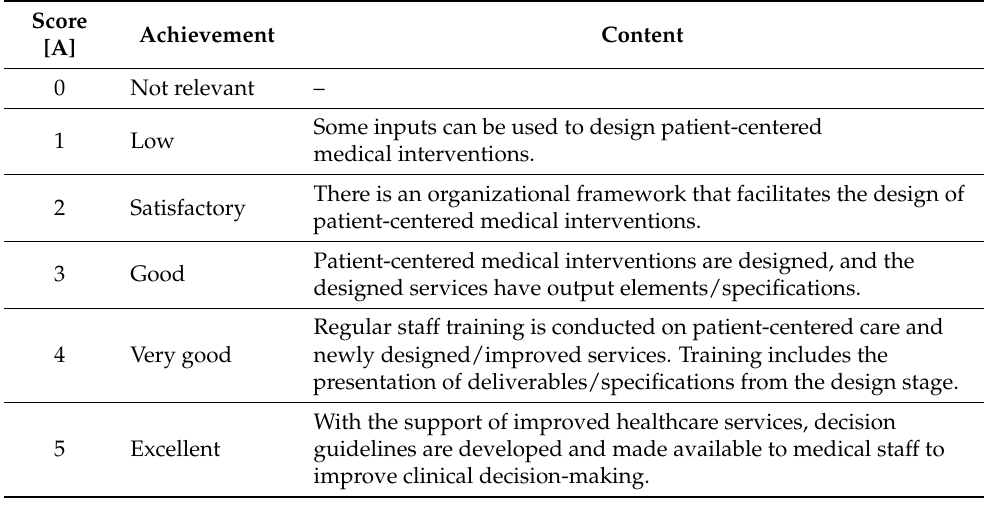
Table A4. Scale for indicator PB3—Quality assurance of patient-centered medical interventions.